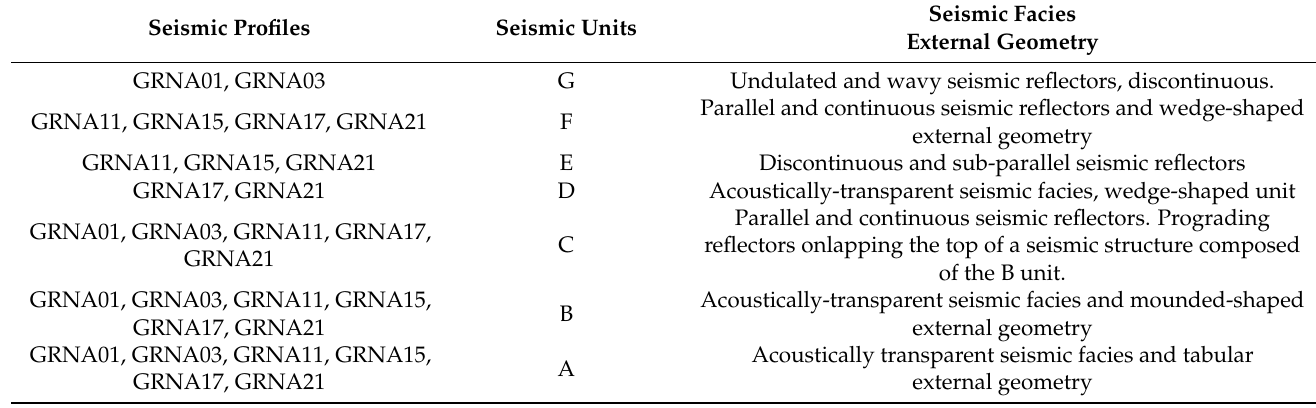
Table 1. Seismic units of the eastern Bay of